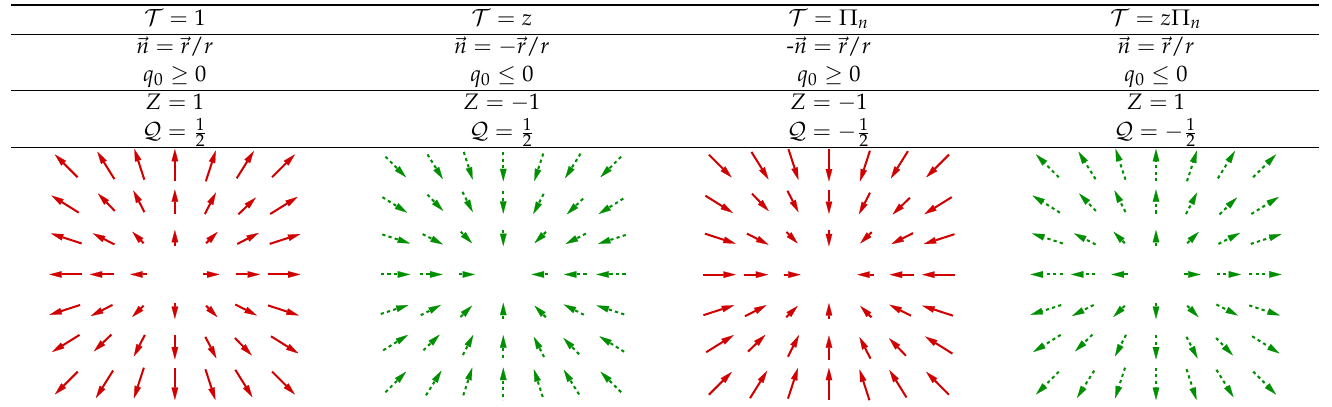
Table 1. The transformations T of the hedge-hog configuration in the first column, see Equation (24), modify the fields (cid:126) n and q 0 and the topological quantum numbers Z and Q . The diagrams show the imaginary components (cid:126) q = (cid:126) n sin α of the soliton field, in full red for the hemisphere with q 0 > 0 and in dashed green for q 0 <